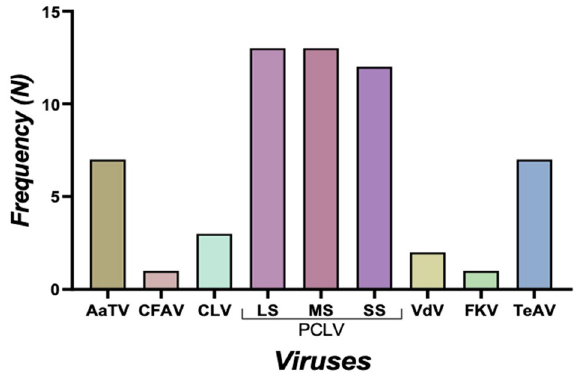
Figure 1. Frequency distribution of the viruses found in the mosquito pools. AaTV Aedes aegypti totivirus, CFAV cell fusing agent virus, CLV Chaq-like virus, PCLV Phasi Charoen-like phasivirus (L segment, M segment,